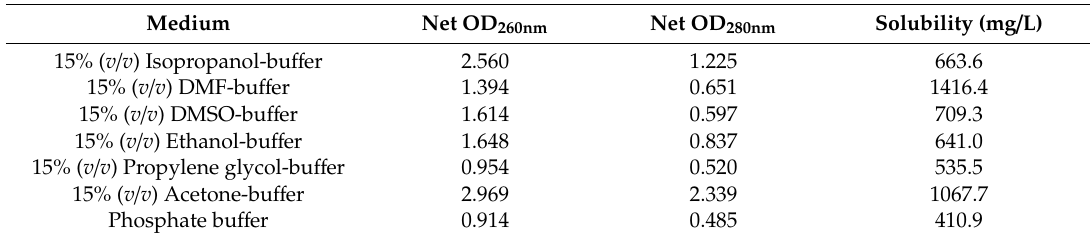
Table 2. Solubility of 4-(trifluoromethyl)acetophenone in di ff erent organic solvent-aqueous media and e ff ect of various cosolvents on cell membrane permeability.